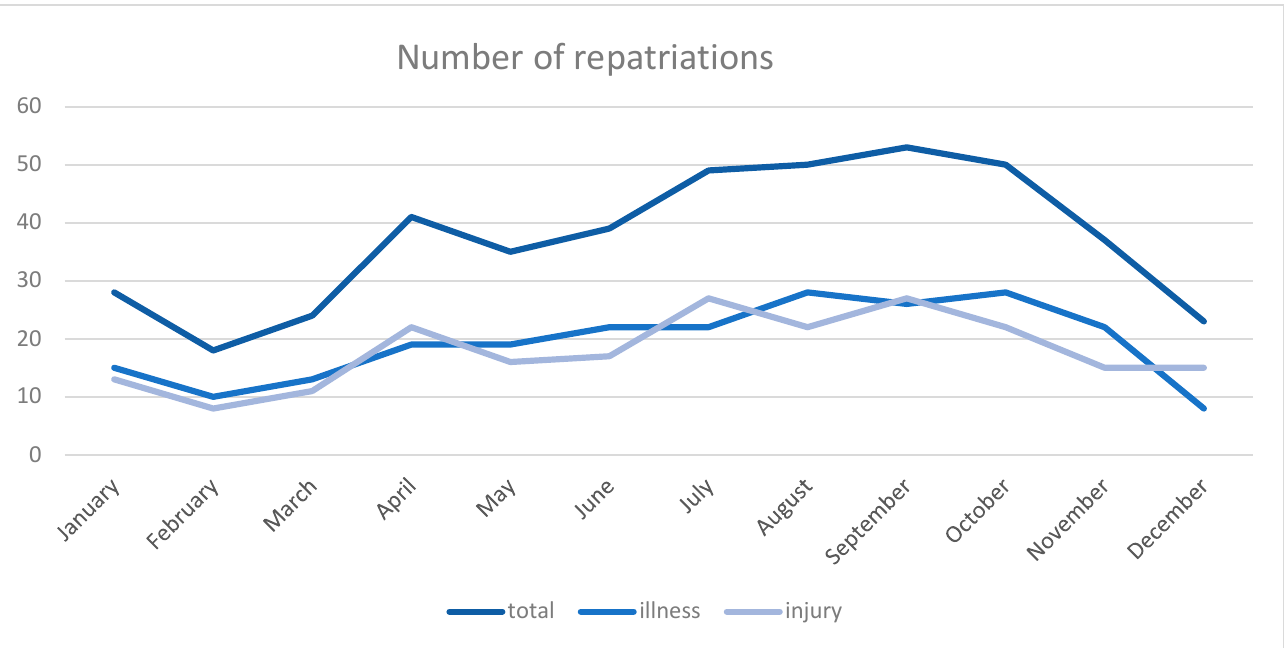
Figure 2. Cumulated number of repatriations by month for the years 2013–2018.